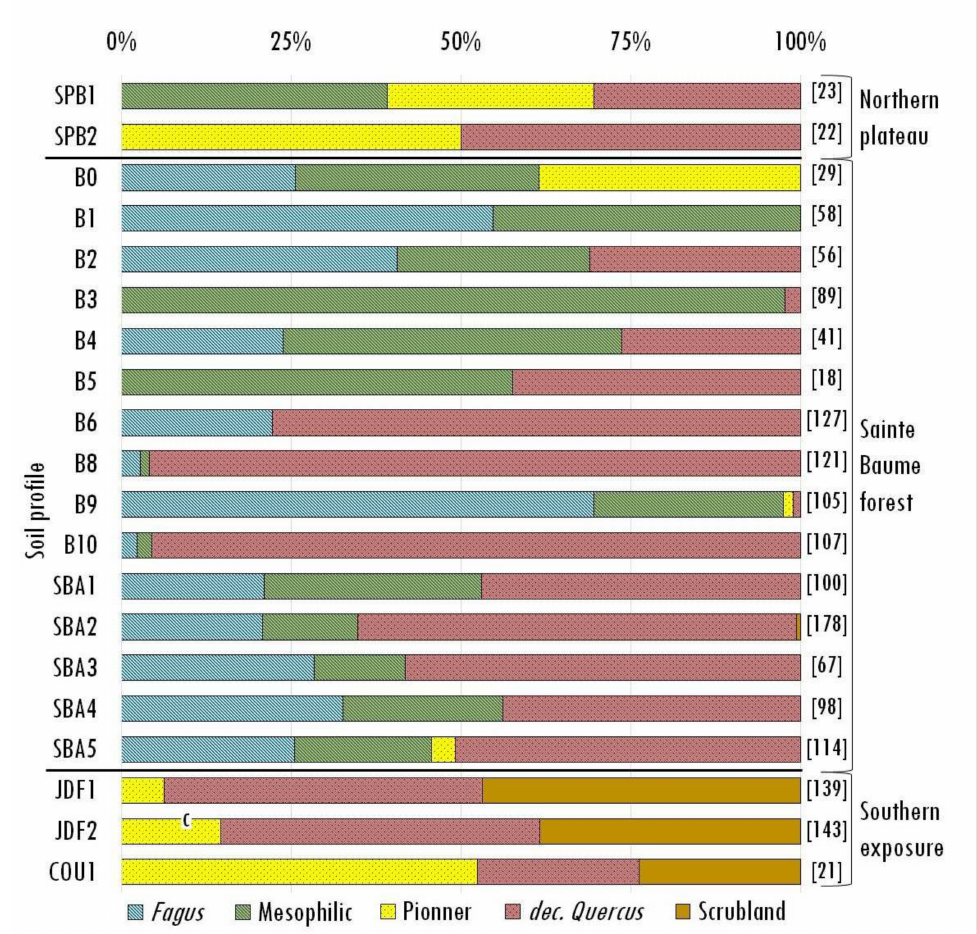
Figure 5. Taxon frequency in the identified soil charcoal assemblages, represented by taxonomic groups with different successional stages (pioneer: Juniperus and Pinus ; scrubland: Ilex , Rosmarinus , Crataegus , Cistus , Pistacia , Phillyrea , evergreen Quercus , Arbutus and Erica ; mesophilic: Sorbus , Tilia , Acer , Ulmus and Taxus ), except that the two most frequent taxa are represented separately ( Fagus and deciduous Quercus